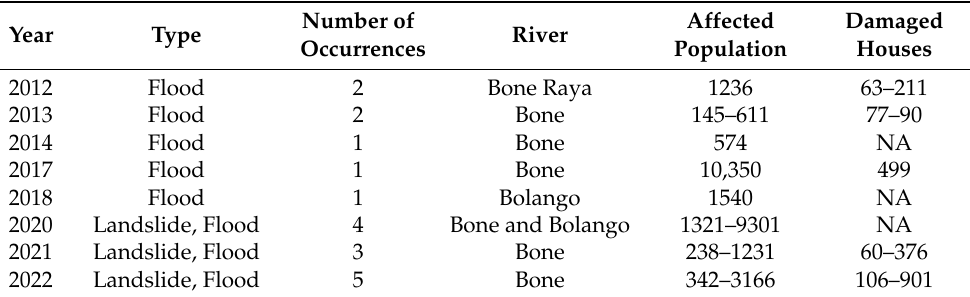
Figure 10. Time series of the monthly precipitation in the study area. Table 4. Disasters that occurred in Bone Bolango from 2012 to 2022.